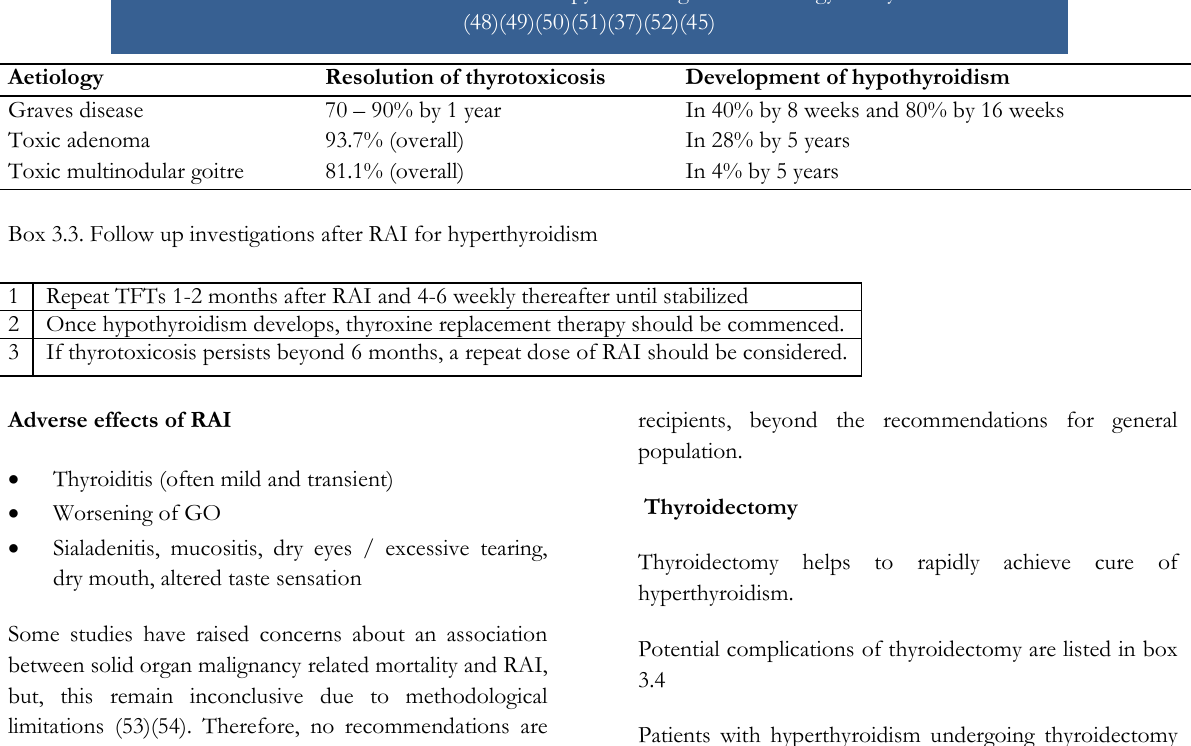
Table 3.10. Outcomes of radioiodine therapy according to the aetiology of